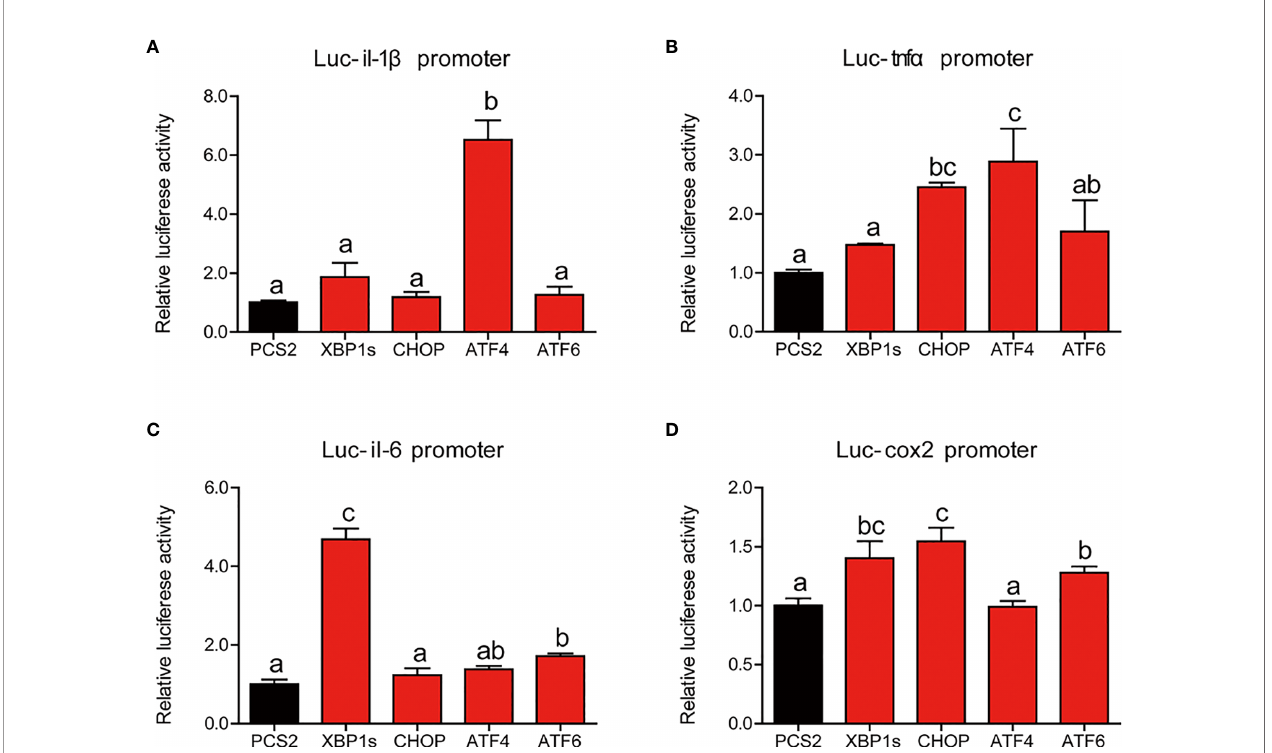
FIGURE 8 | Relative dual-luciferase activity analysis of UPR sensors in promoters of proin fl ammatory genes in HEK293T cells. The promoter activities of il-1 b (A) , tnf a (B) , il-6 (C) , and cox2 (D) were measured (n = 4). il-1 b , interleukin-1 beta; tnf a , tumor necrosis factor alpha; il-6 , interleukin-6; cox2 , cyclooxygenase 2. Results were analyzed using Tukey ’ s test [values without the same letter indicate signi fi cant difference ( P < 0.05)], and they were expressed as mean ± standard